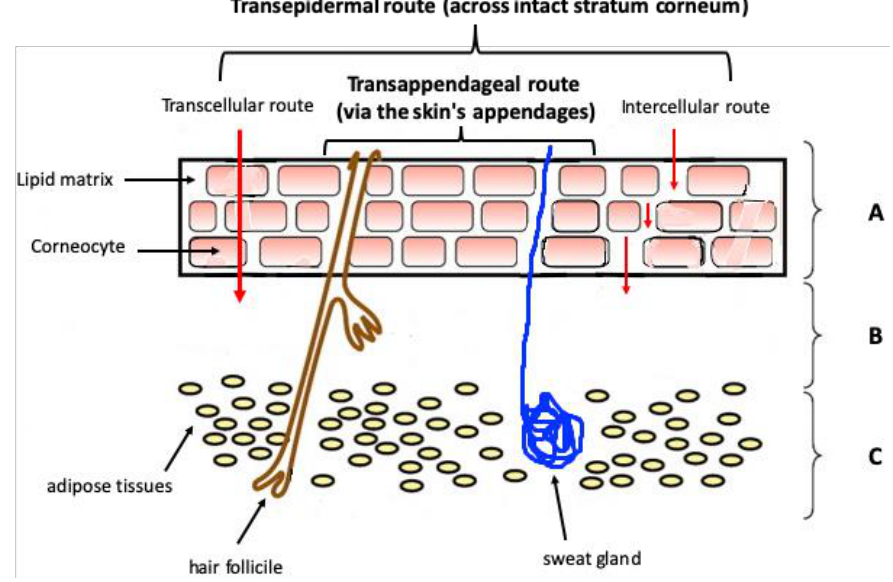
Figure 1. Diagrammatic illustration of the skin’s structure and routes of permeation through the skin. A—Epidermis (SC), B—Dermis, C—Subcutaneous layer.